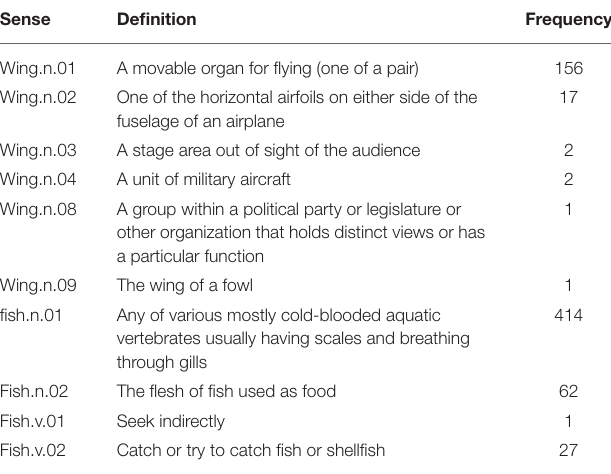
TABLE 5 | Senses appearing in the Princeton WordNet Gloss Tag